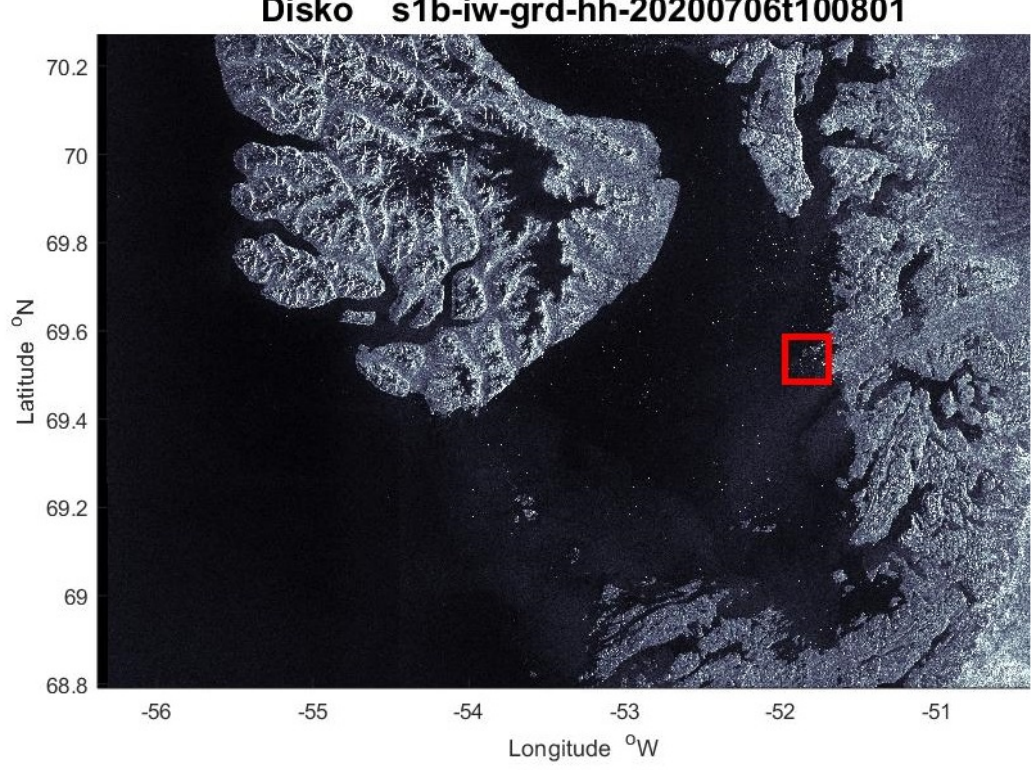
Figure 1. Sentinel-1 (S1) high-resolution ground range detected (GRDH) interferometric wide (IW) synthetic-aperture radar (SAR) tile of the Disko Bay. The red box indicates the Ilulissat Icefjord, probably the fastest-flowing ice glacier and iceberg producer in the world.